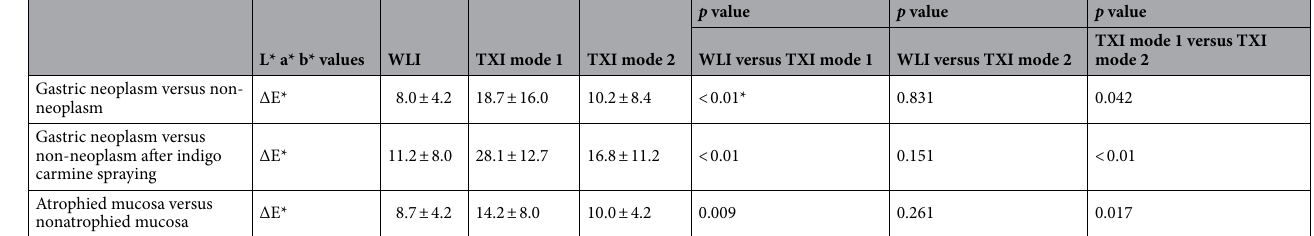
Table 3. Objective evaluations using color differences (ΔE*; mean ± SD ). WLI white-light imaging, TXI mode 1 Texture and Color Enhancement Imaging mode 1, TXI mode 2 Texture and Color Enhancement Imaging mode 2, indigo-WLI WLI after indigo carmine spraying, indigo-TXI mode 1 TXI mode 1 after indigo carmine spraying, indigo-TXI mode 2 TXI mode 2 after indigo carmine spraying, SD standard deviation, NS not significant. p value: exact Wilcoxon signed-rank